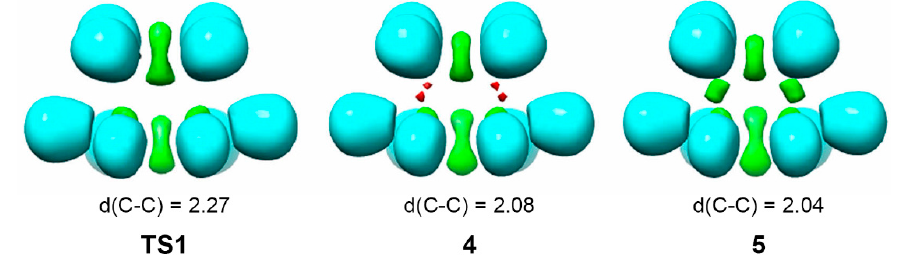
Figure 2. ELF valence basins in TS1 and in the structures defining phase V , structure 4 , and phase VI , structure 5 , involved in the synchronous C–C single bond formation in the non-polar DA reaction between butadiene 1 and ethylene 2 . The pseudoradical centres involved in the C–C bond formation are characterised by the four V(C) monosynaptic basins depicted in red in structure 4 . ELF valence basins were represented at an isosurface value of 0.8 and C–C distances are given in Angstroms. Calculations were performed at the B3LYP/6-31G(d) level.